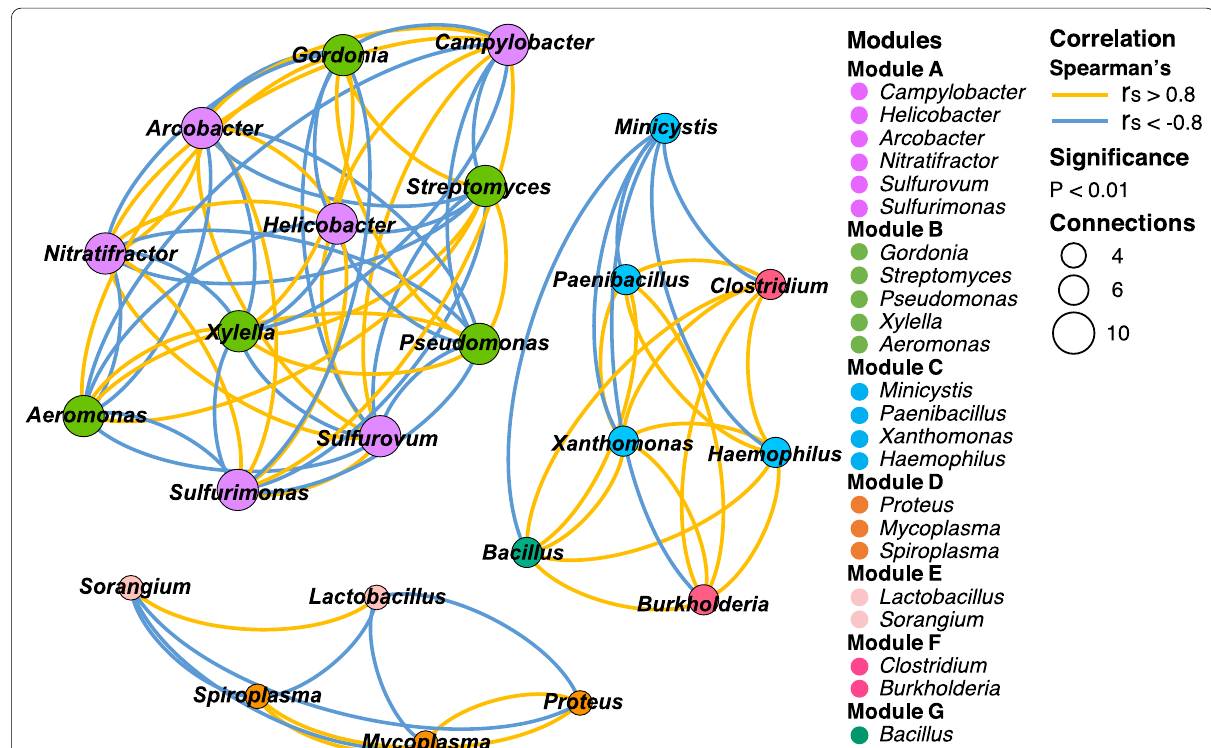
Fig. 3 Correlation‑based network of intestinal bacteria genera (relative abundance analysis displays the intra‑associations within each sub‑community and inter‑associations between sub‑communities. Node size is proportional to the number of connections (i.e. degree of connectivity). Connection between nodes represents strong [Spearman correlation efficiency > 0.8 (yellow) or < 0.8 (blue)] and significant ( p ‑value < 0.01) correlation. The same colour of nodes shows their highly modularised (clustered) property − within the